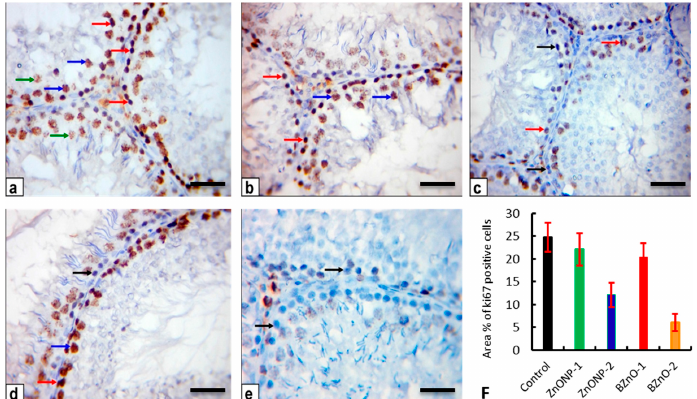
Figure 10. Photomicrograph of rat testes, showing positive brown Ki-67 immunostaining (scale bar = 50 μ m): ( a ) control rats; ( b ) ZnONP-1 rats; ( c ) ZnONP-2 rats; ( d ) BZnO-1 rats; ( e ) BZnO-2 rats. Arrows in the panels are showing strong (red arrows), moderate (blue arrows), weak (green arrows), and negative (black arrows) immunoreactions in the nuclei of the spermatogonia and primary spermatocytes. ( f ) Area % of Ki-67 immunostaining positive cells. All the values are expressed as the mean ± standard error of the mean. Statistical significance was considered at a p < 0.0001. 4. Discussion Not all levels of nanoparticles (NPs) have a protective or non-toxic impact on sper- matogenesis [27], compared to its traditional forms. Recent studies deducted that some NP levels have a toxic effect on male germ cells [28] through the creation of reactive oxy- gen species (ROS), resulting in oxidative damage [29]. Therefore, the present study’s aim was to determine the difference between the effect of ZnONPs and its bulk form in two doses on male reproductive performance, testicular antioxidants, reproductive hormones, gene expression, and histopathology. This study hypothesized that the ZnONPs could positively affect the male rat reproductive system compared to its traditional form but at a certain level as its higher level could hurt it. The current study showed that ZnONP-1 had improved male sexual performance. However, no difference was found between BZnO-1 and the control for all parameters, except that the ejaculatory latency and sperm count were higher in BZnO-1 than in the control. In contrast, ZnONP-2 and BZnO-2 hurt sexual performance, with a more adverse effect for BZnO-2. This could be attributed to the NPs’ administration at low doses, which might have a defensive impact through their antioxidant processes, while high doses could have a harmful e ff ects [30]. This was supported by [31], who reported that ZnONP at a low dose (5 mg/kg) could have a beneficial e ff ects on male reproduction. However, high doses (50, 150, 300, and 350 mg/kg) could act as testicular toxicants in mice. The au- thors in [32] also revealed that ZnONP treatment in mice at low doses is relatively bio- compatible as a nutritional additive after long-term feeding when compared to their mi- croparticles. However, [33] revealed that ZnONPs (10 mg/kg bwt) increased sperm quan- tity and motility in diabetic rats. On the other hand, [7] reported that the intranasal irriga- tion with zinc sulfate solution of male mice leads to abolishing sexual behavior in the mating test with an estrous female. Normal sperm functioning requires a low level of reactive oxygen species (ROS) physiologically, and if the ROS levels are above the physiological level, sperm functioning deteriorates [34]. ROS and their metabolites are capable of targeting DNA, proteins, lipids,